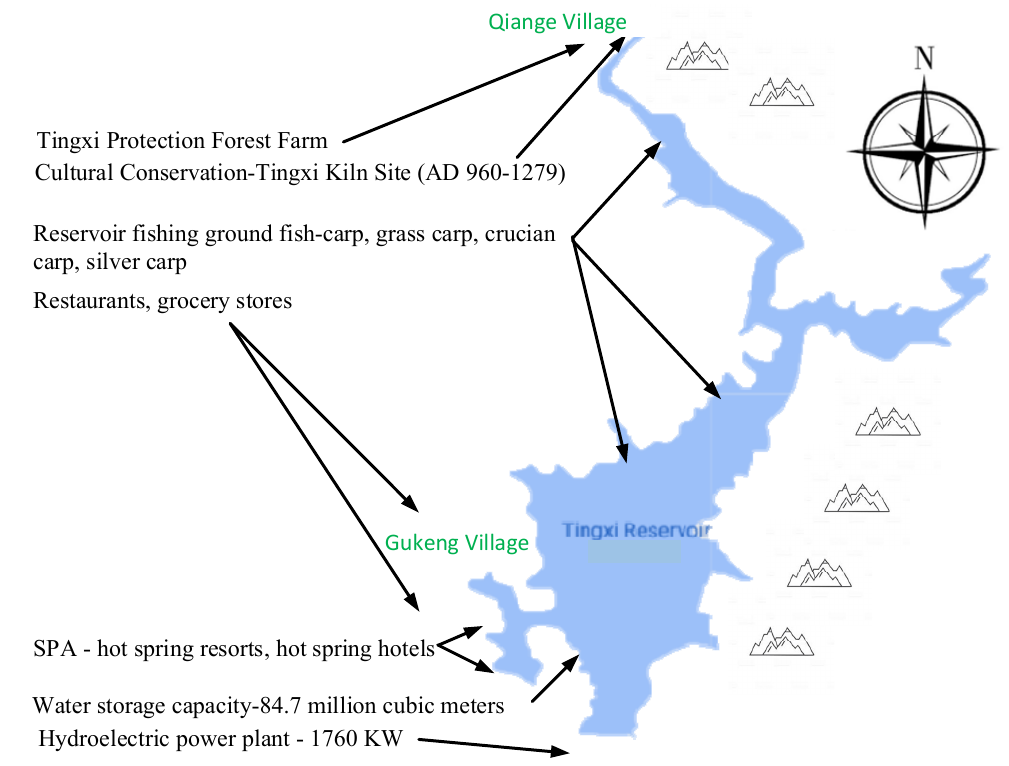
Figure 1. Distribution map of the tourism resources at Tingxi Reservoir.